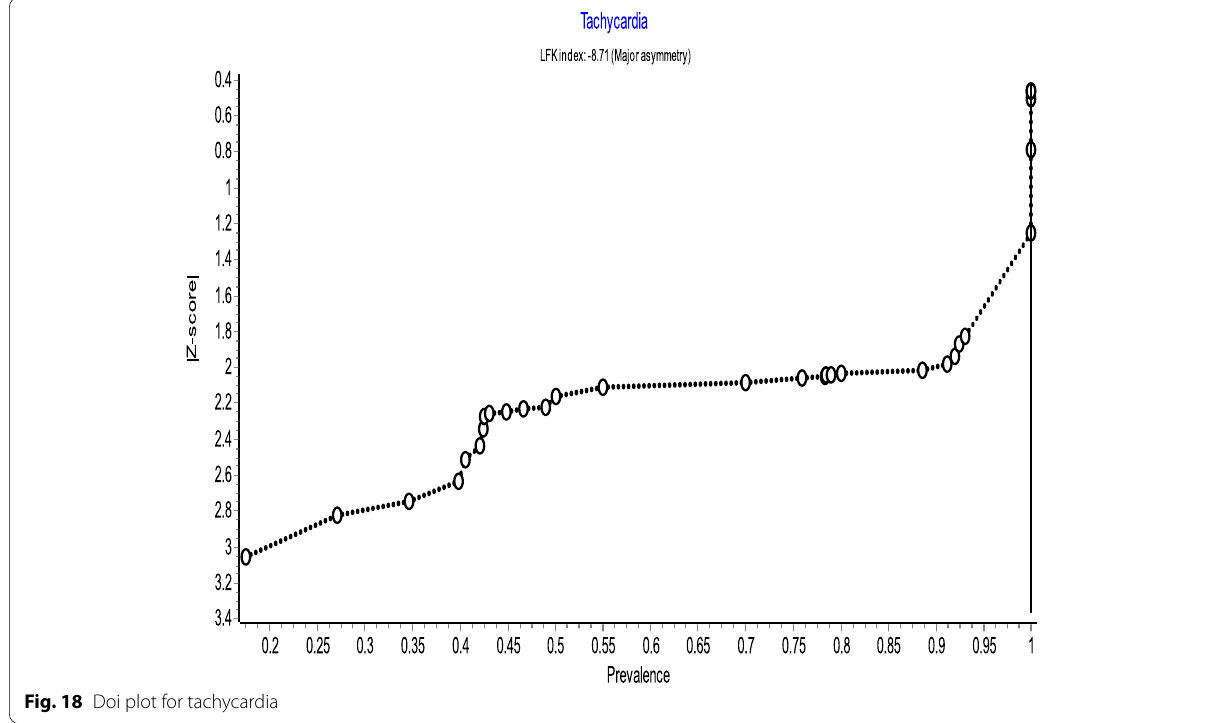
Fig. 18 Doi plot for tachycardia